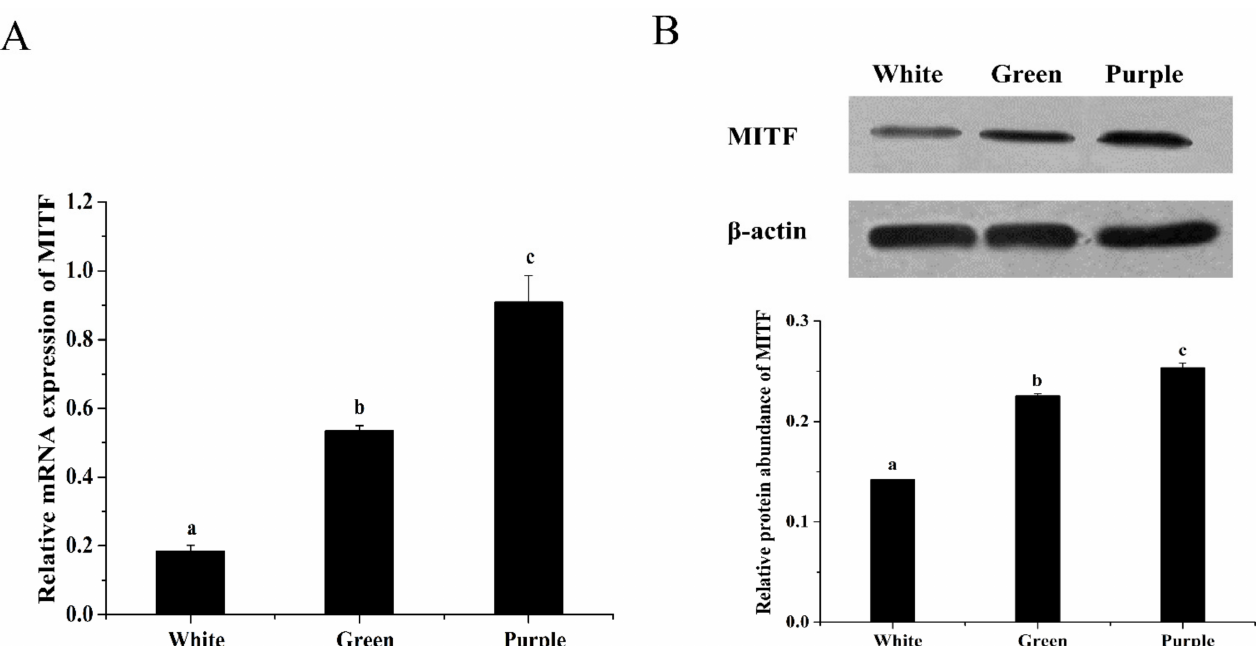
Figure 1. Relative expression levels of MITF mRNA and protein in the body wall of white, green, and purple A. japonicus . ( A ) The MITF mRNA expression levels relative to β -actin mRNA levels were examined by qPCR, and the difference among different color morphs was analyzed. ( B ) Total protein (10 µ g) was loaded in each line for Western blot analysis, and β -actin was used as a loading control. The relative protein abundance of MITF was calculated as relative expression values to the control group. Different letters (a, b, c) indicate significant differences among different color morphs ( p <